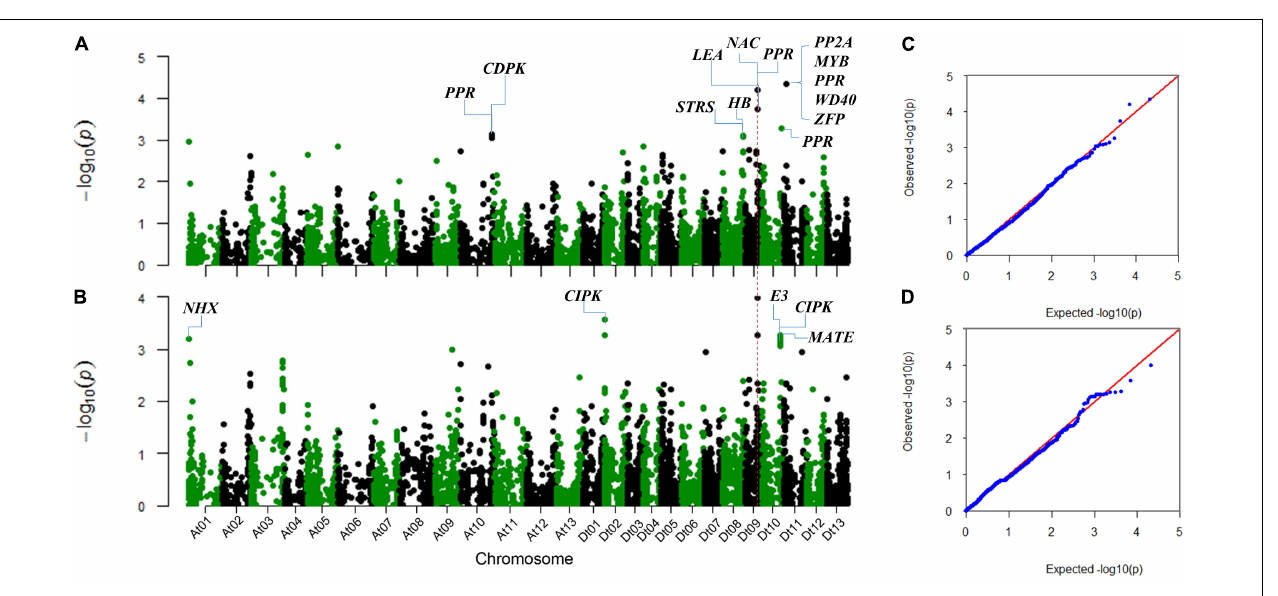
FIGURE 2 | Manhattan and QQ plots for the two salt-tolerance-related traits. (A) Manhattan plot for RSR. (B) Manhattan plot for STL. (C) QQ plot for RSR. (D) QQ plot for STL. The corresponding Arabidopsis thaliana homologous genes linked to the significant SNPs are